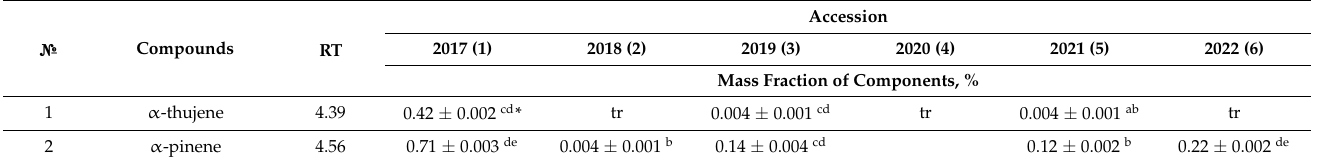
Table 1. Component composition of the essential oil of Hyssopus officinalis f. cyaneus